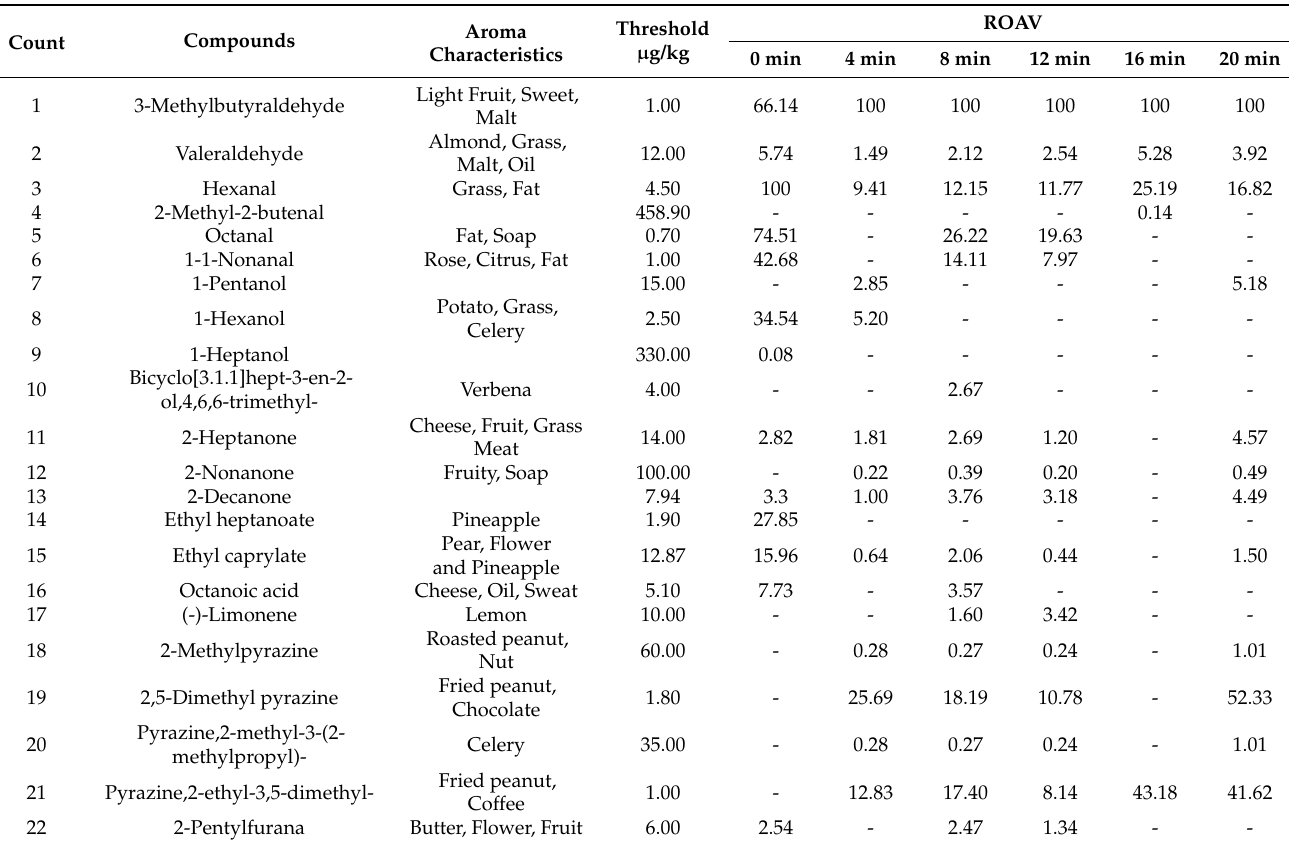
Table 2. ROAV of defatted tiger nut flour.